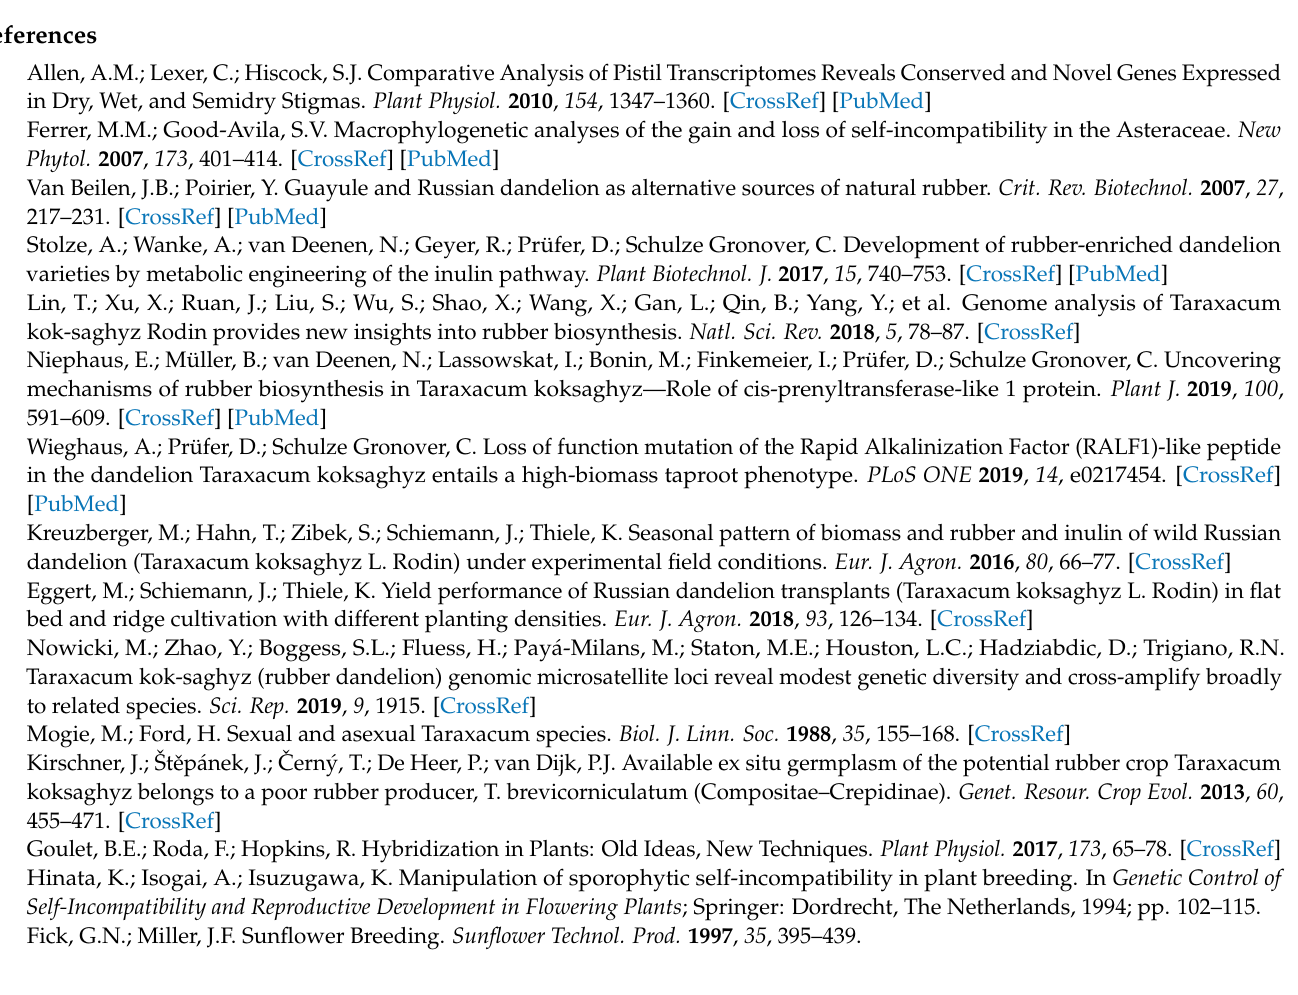
Table S8: Subsets of DEGs used for Venn analysis, Tables S9–S10: GO Enrichment analysis for T1 vs. T0 and T2 vs.